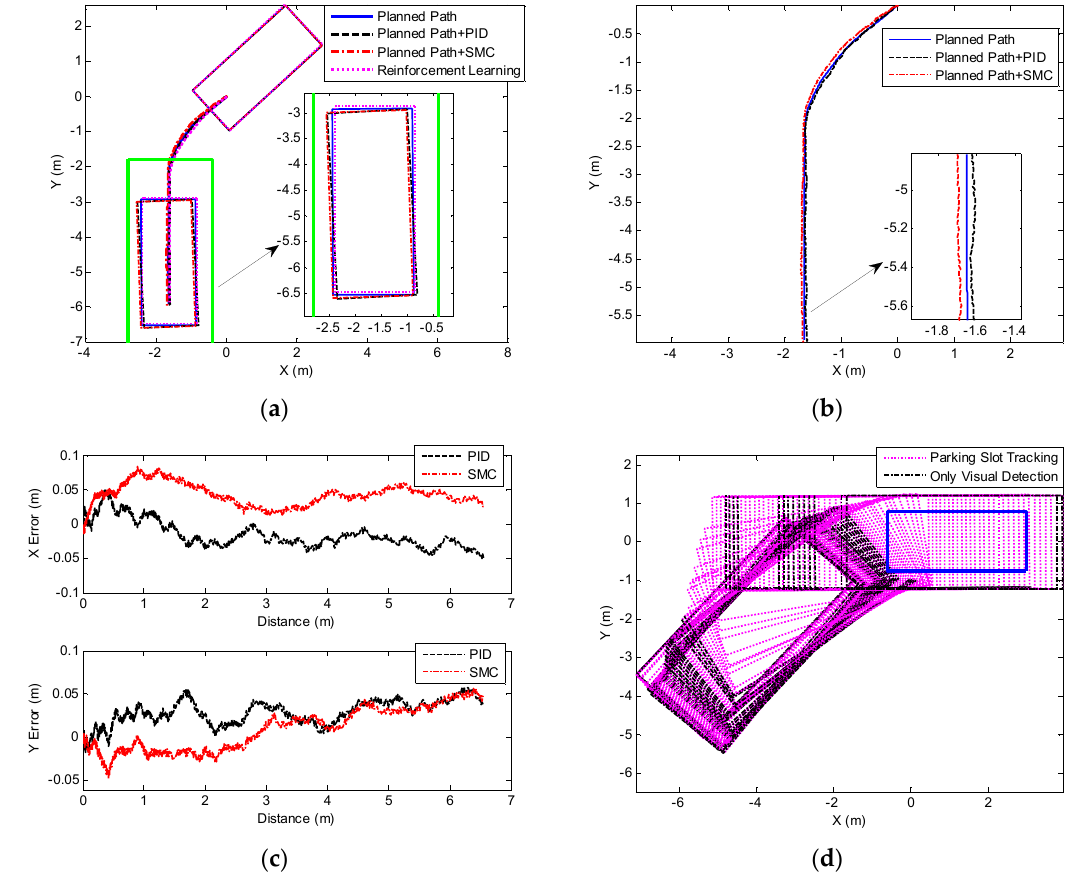
Figure 21. Experimental results of 45° perpendicular parking. ( a ) Parking performance of different methods; ( b ) and ( c ) represent the control effect and error of different path tracking methods, respectively. ( d ) Parking slot detection and tracking in the parking process. Table 2. Experimental data of 45° perpendicular parking.